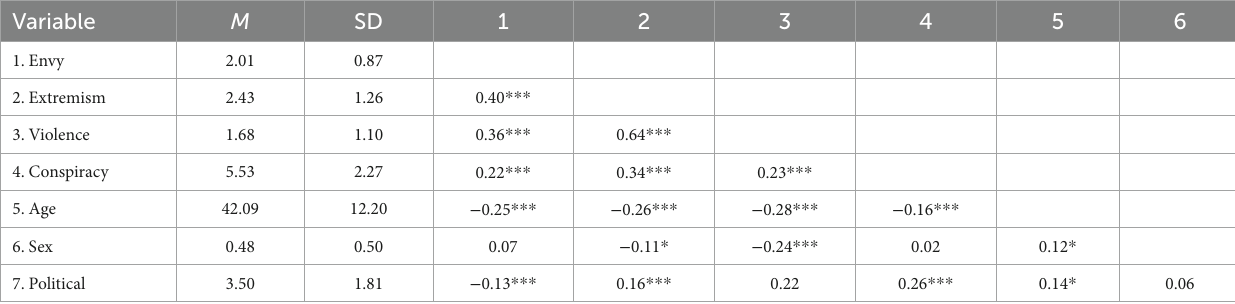
TABLE 1 Descriptive statistics and correlations for study variables.